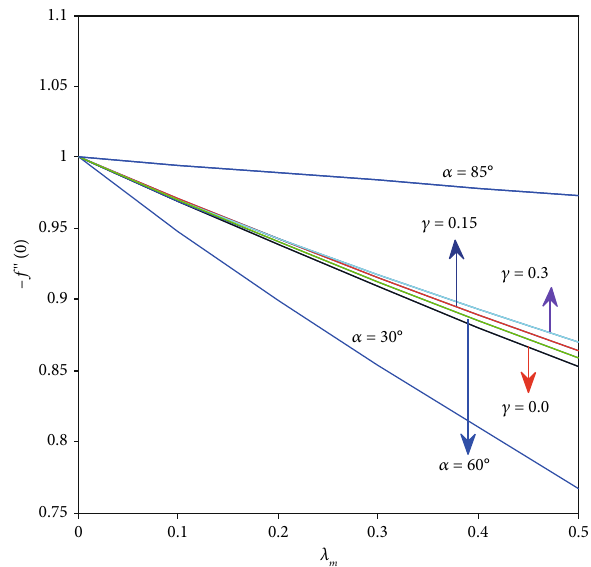
Figure 33: E ff ects of curvature and inclination parameters on the skin friction coe ffi cient.